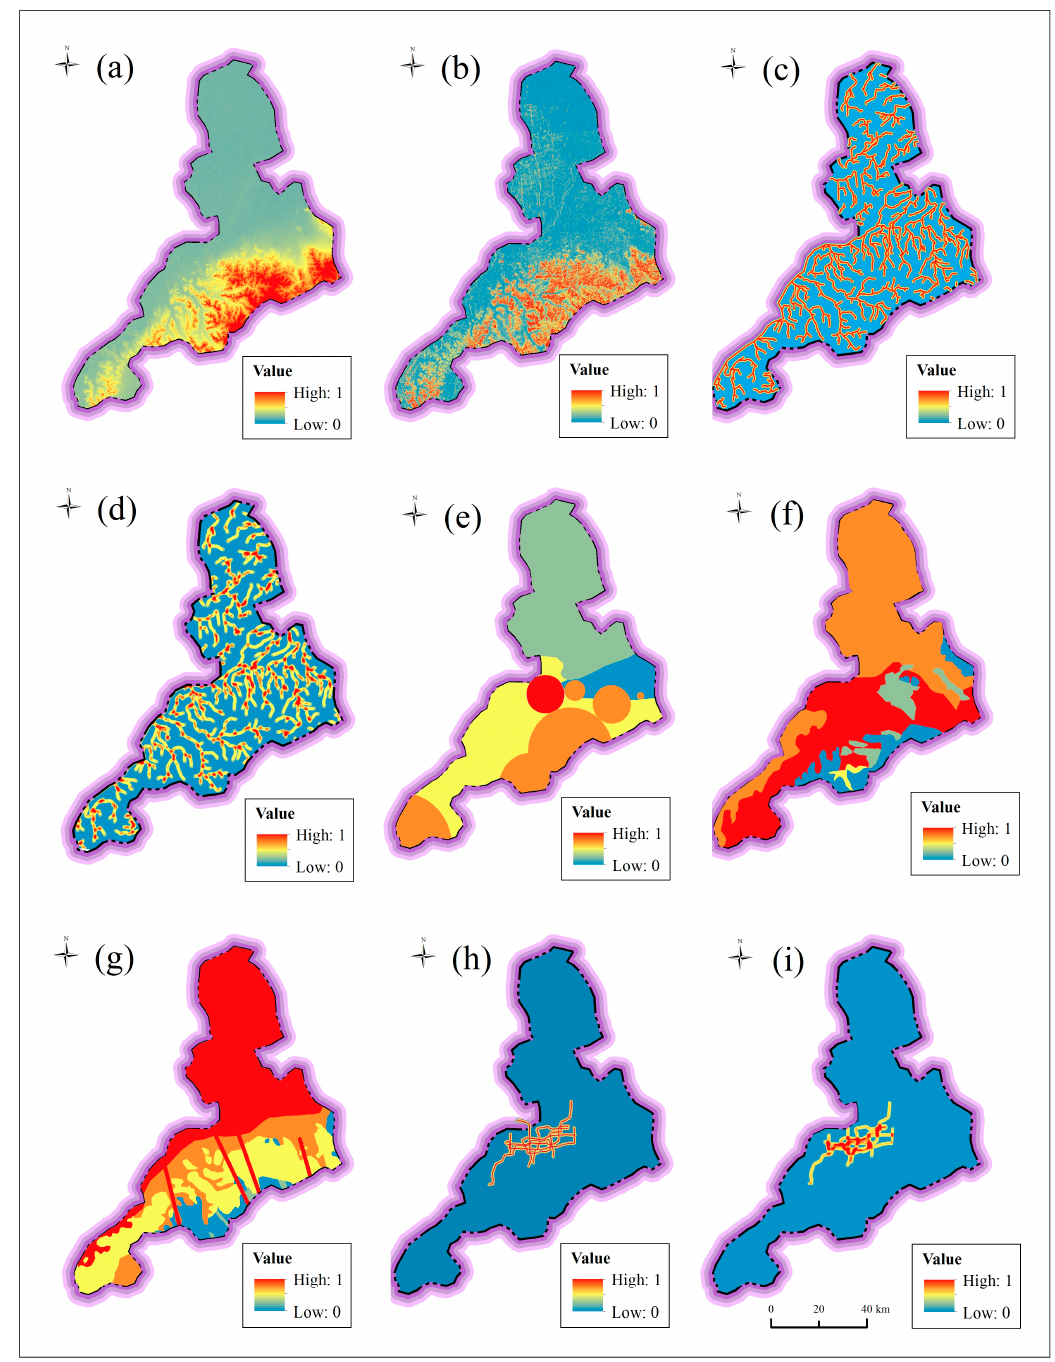
Figure 14. Normalized factors of assessment system: ( a ) elevation; ( b ) slope; ( c ) river proximity; ( d ) river density; ( e ) spring groups; ( f ) hydrogeology; ( g ) geology; ( h ) metro line proximity; and ( i ) metro line density.